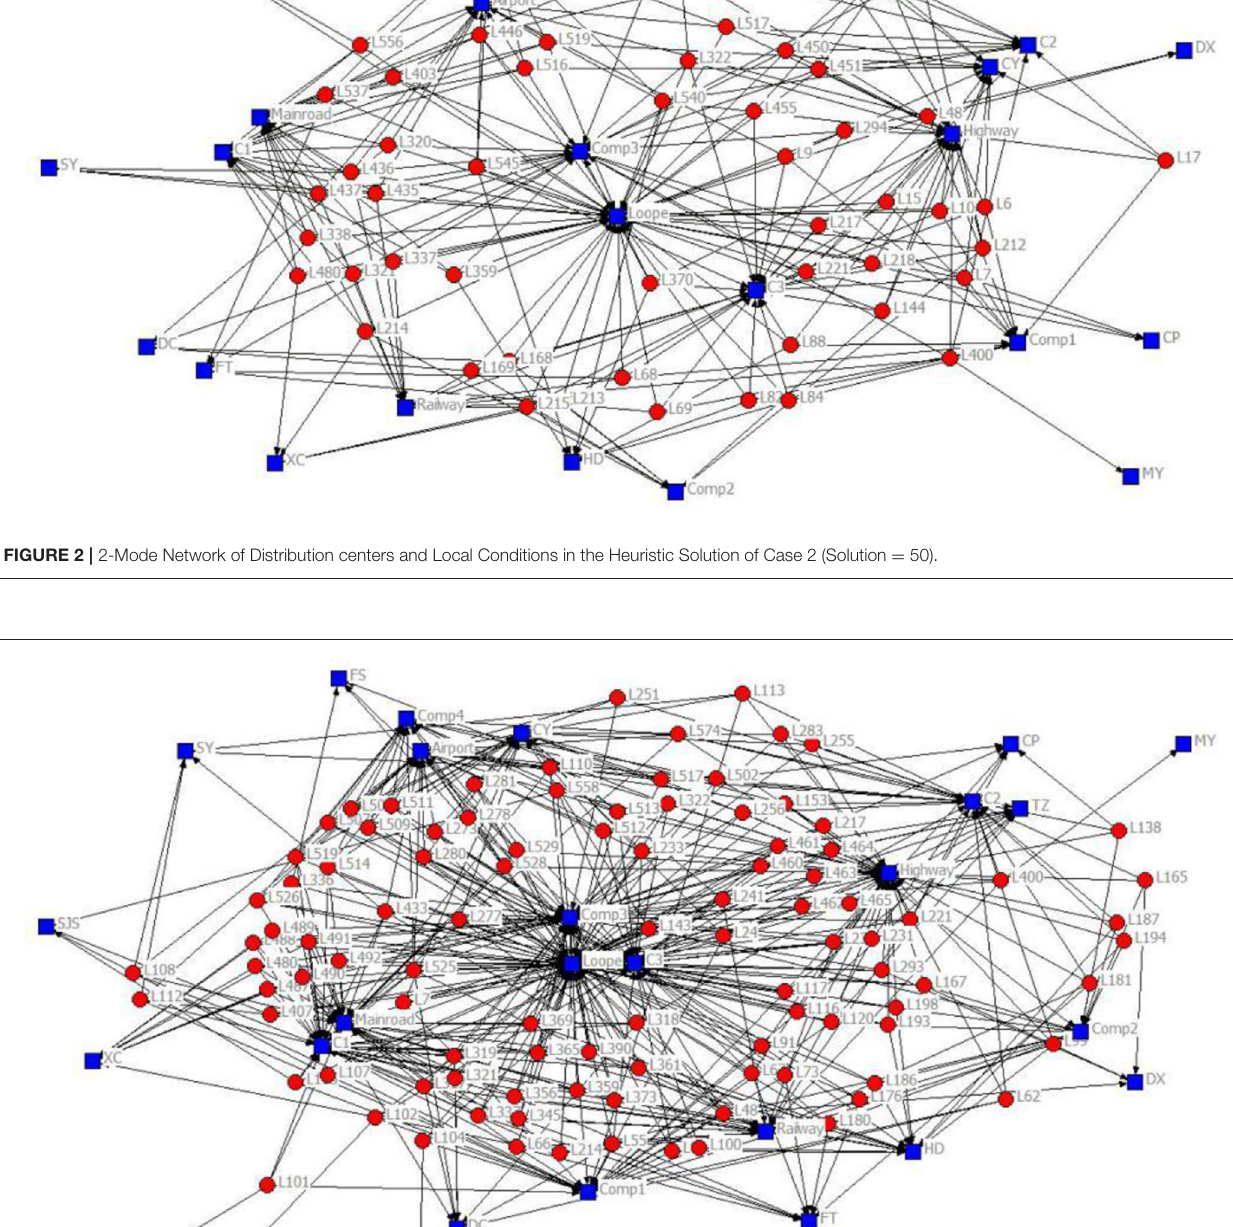
Frontiers in Public Health |